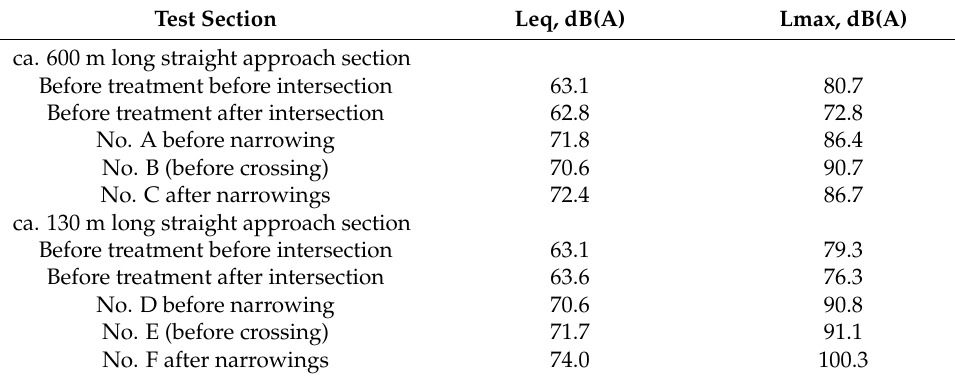
Table 3. Compilation of noise